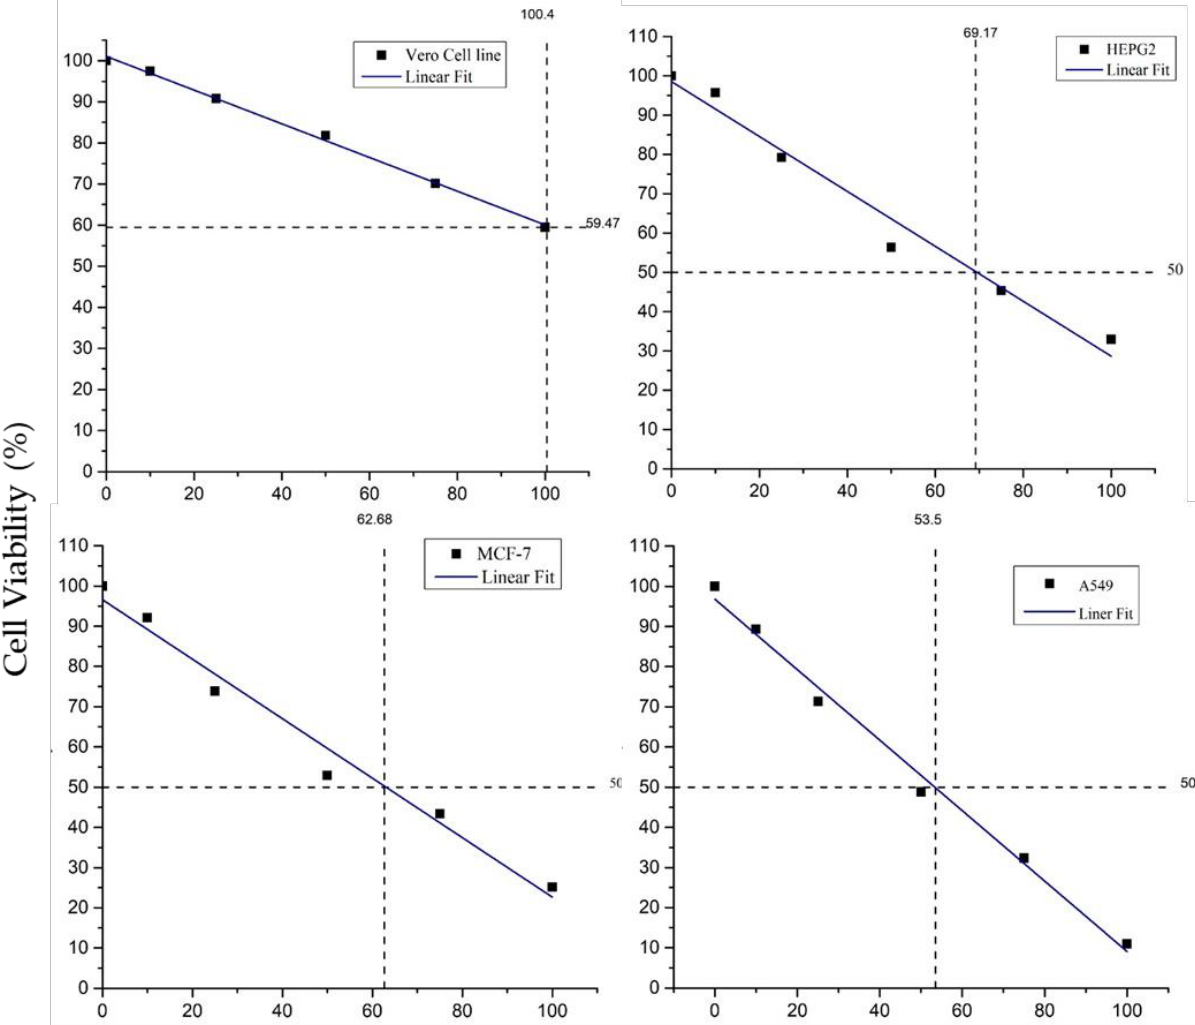
Figure 5. In vitro cytotoxic effect of AgNPs on normal Vero cells and cancerous cells, such as HepG2, A549 and MCF-7 cells, were analysed with an MTT assay showing IC 50 values.